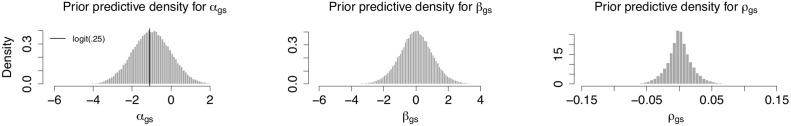
Prior predictive distributions. Prior predictive distributions for αgs and βgs along with the implied prior predictive distribution for excess risk of breast cancer metastasis.